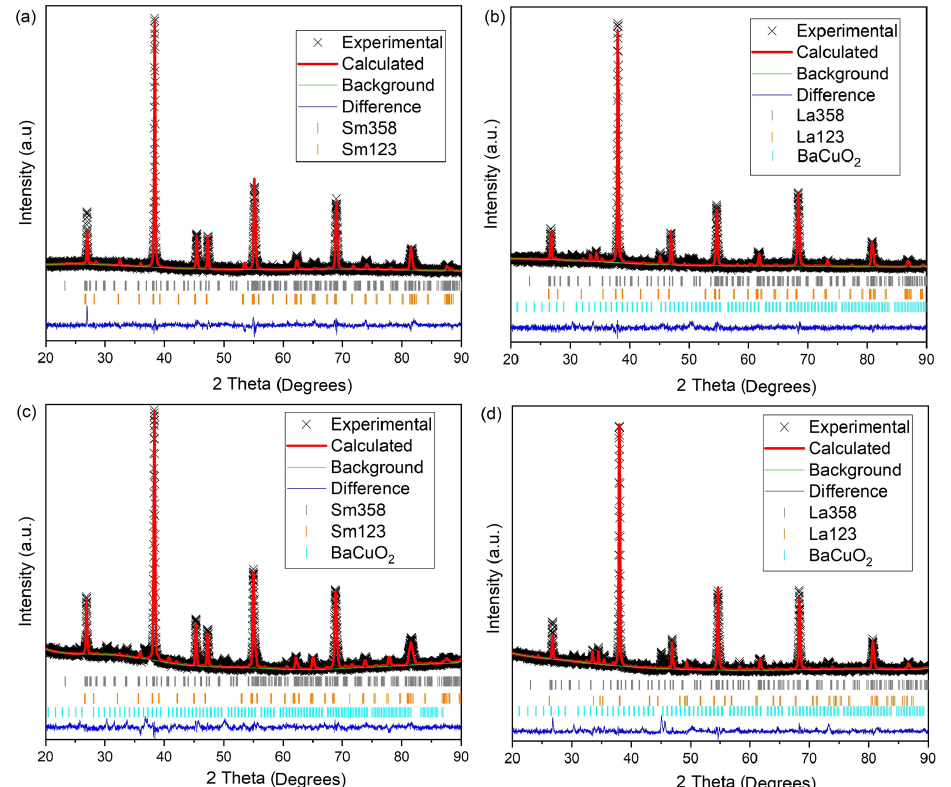
Ba Cu O and La Ba Cu O obtained by combustion (a, b) and solid-state reaction (c, 3 5 8 18-δ 3 5 8 18-δ